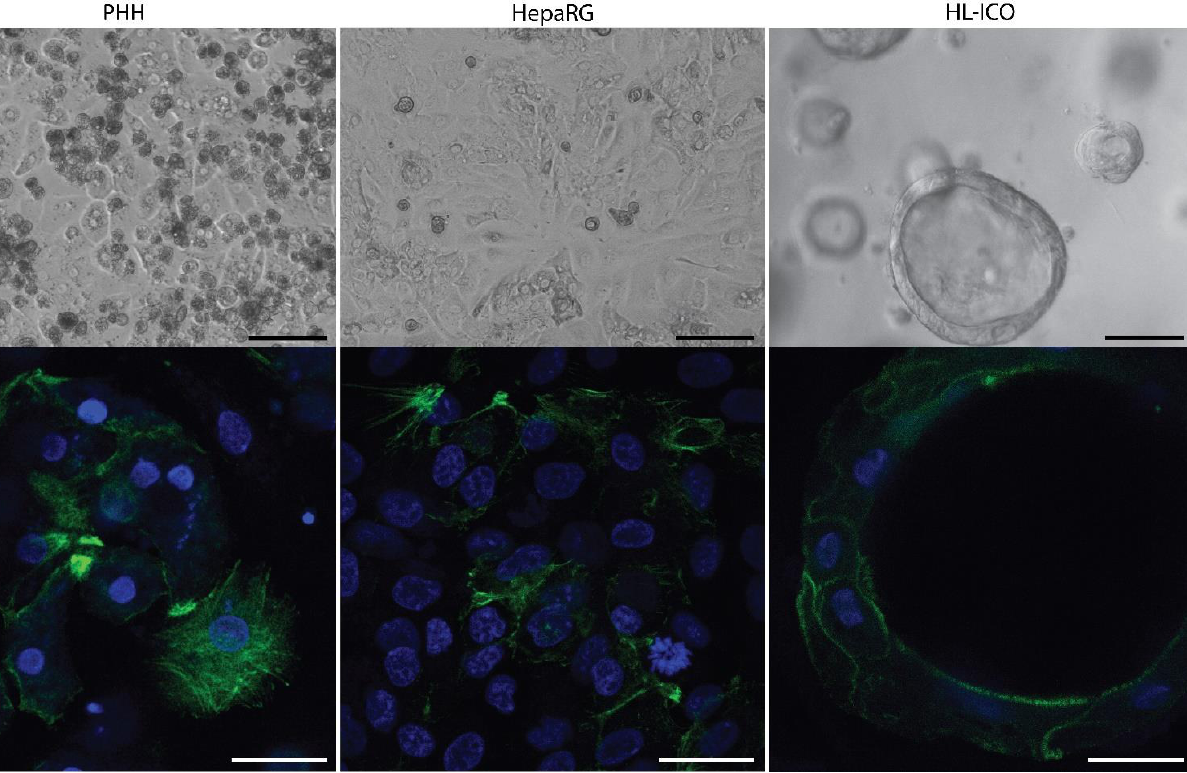
Figure 1. Morphology of primary human hepatocytes (PHHs), hepatic cell line HepaRG and hepato- cyte-like intrahepatic cholangiocyte organoids (HL-ICOs) on differentiation day 12. Top: Brightfield pictures of morphology. Scale bar = 100 µm. Bottom: Phalloidin staining (green) of filamentous actin. Scale bar = 25 µm.